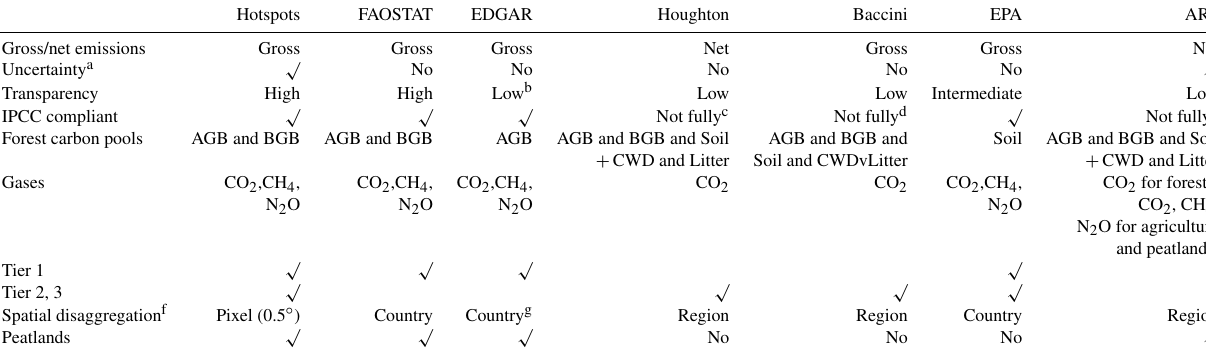
Table 1. Differences and similarities of the assessed AFOLU datasets.